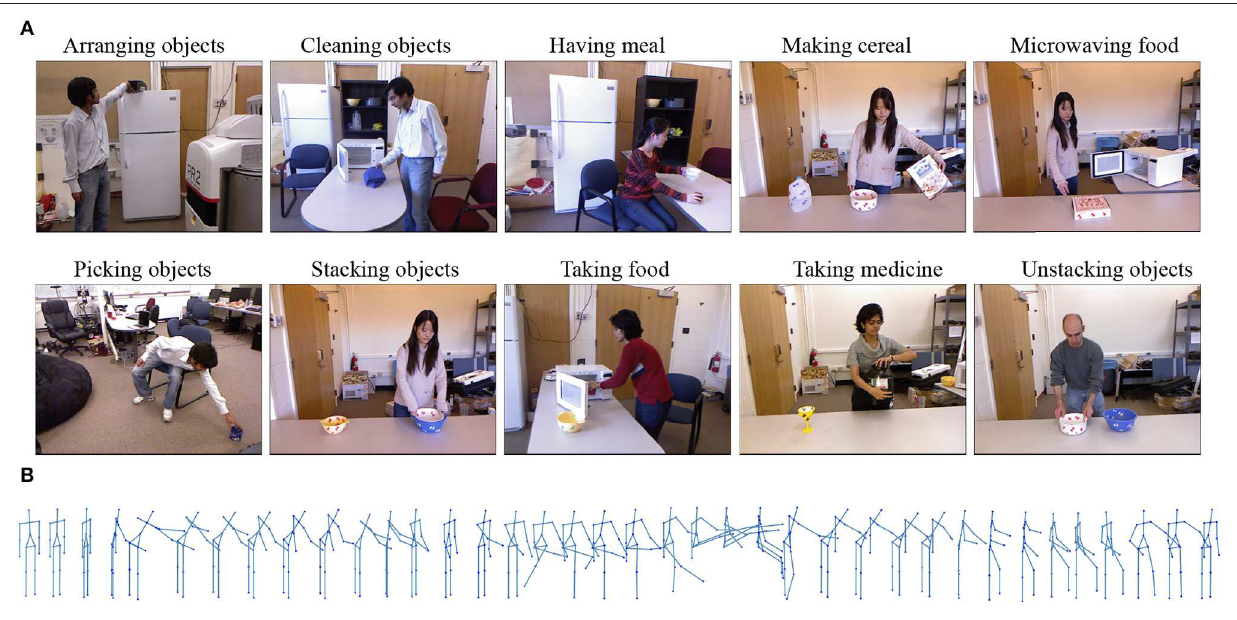
FIGURE 4 | The CAD-120 dataset. (A) Examples of high-level activities from the dataset. (B) A skeleton sequence representing a person standing behind a table and microwaving food: the legs and feet have a very high tracking noise in this position due to not being visible ( Mici, 2018). the neck instead of the head position due to the noisy tracking by selecting two quadruples of joints: [ center torso, neck, left of the head caused by occlusions during actions such as eating hand, left elbow ] and [ center torso, neck, right hand, right elbow ] and drinking and following the skeletal quad features method. We choose